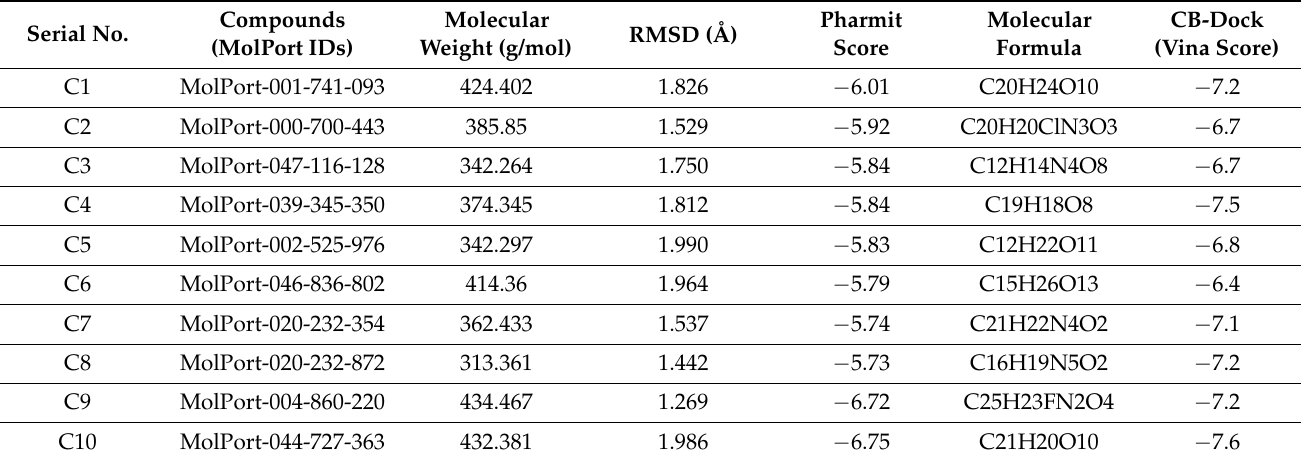
Table 3. CB-Dock scores and RMSD values of top 10 hit molecules obtained against LtPNCA target from virtual screening using Pharmit